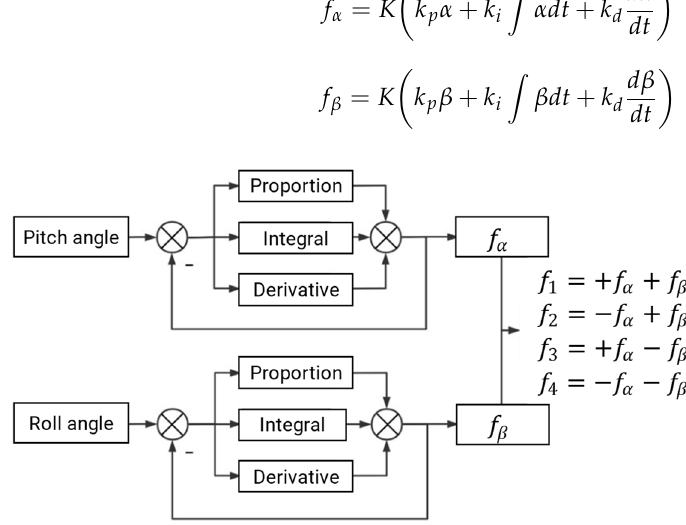
Figure 8. Structure diagram of PID control.